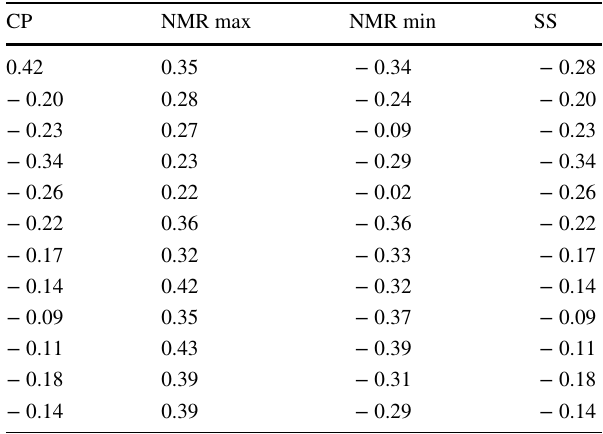
Table 1 Comparison of calculated fractal dimensions with literature values from Table 6 in Appendix 1 (converted to 3 decimal places) Porosity Fractal dimension from capillary pres- sure (CP)